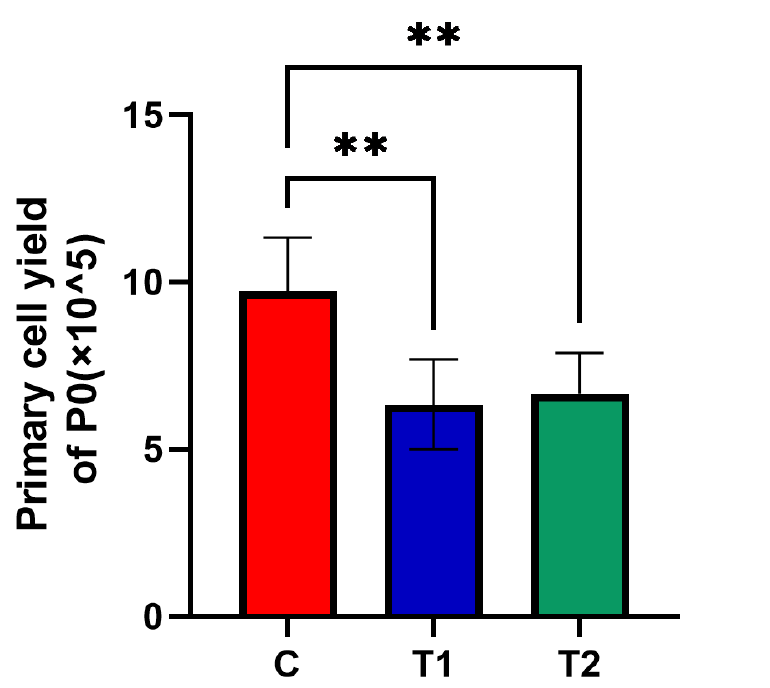
Figure 2. Effects of new cryopreservation strategy on the primary cell yield. The new cryopreserva- tion strategy dramatically decreased the number of harvested primary cells compared with the C group (** p < 0.01).